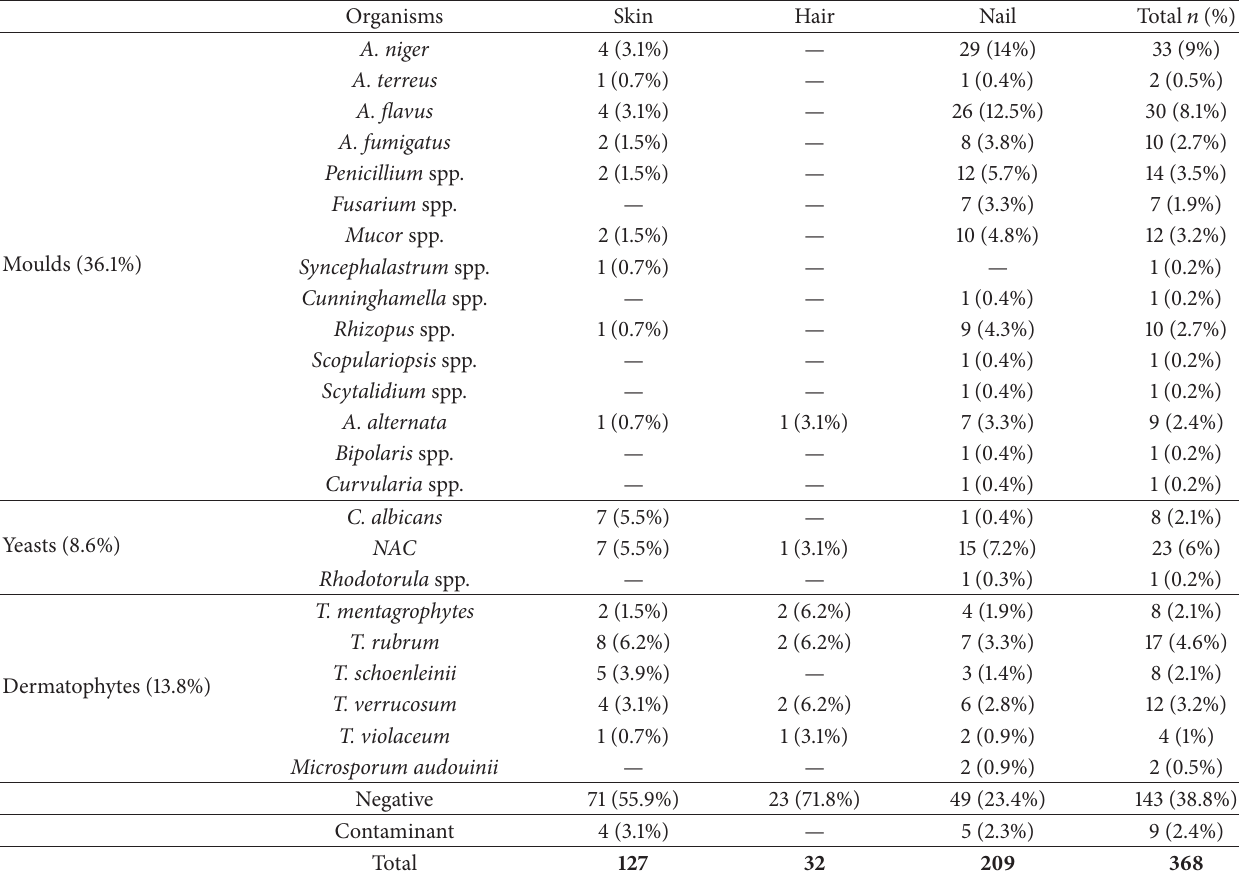
Table 4: Distribution of different isolates from different clinical